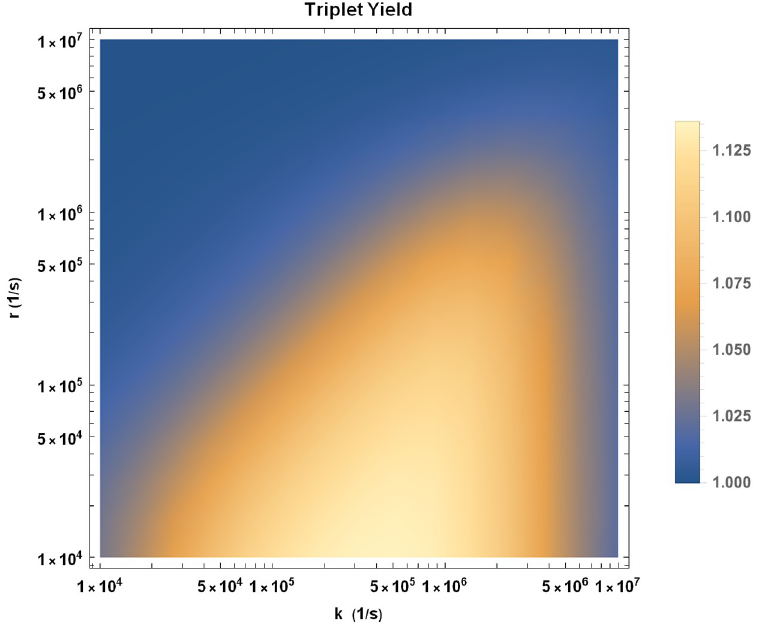
Fig 6. Triplet yield ratio (GMF to HMF) for singlet-born RP containing 17 O in the k − r plane. The values of HFCCs are taken to be a 1 = − 802.9 μT [47] and a 2 = 1886.8 μT .